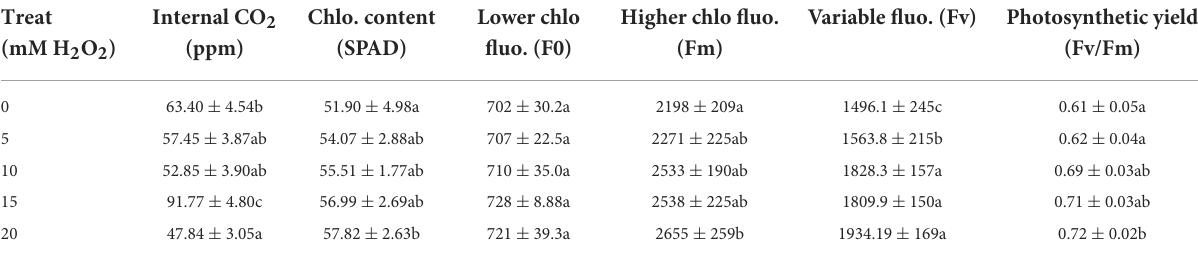
TABLE 2 The effects of H 2 O 2 treatment on leaf chlorophyll content (SPAD) and chlorophyll fluorescence of F. deltoidea plants under drought conditions. Treat